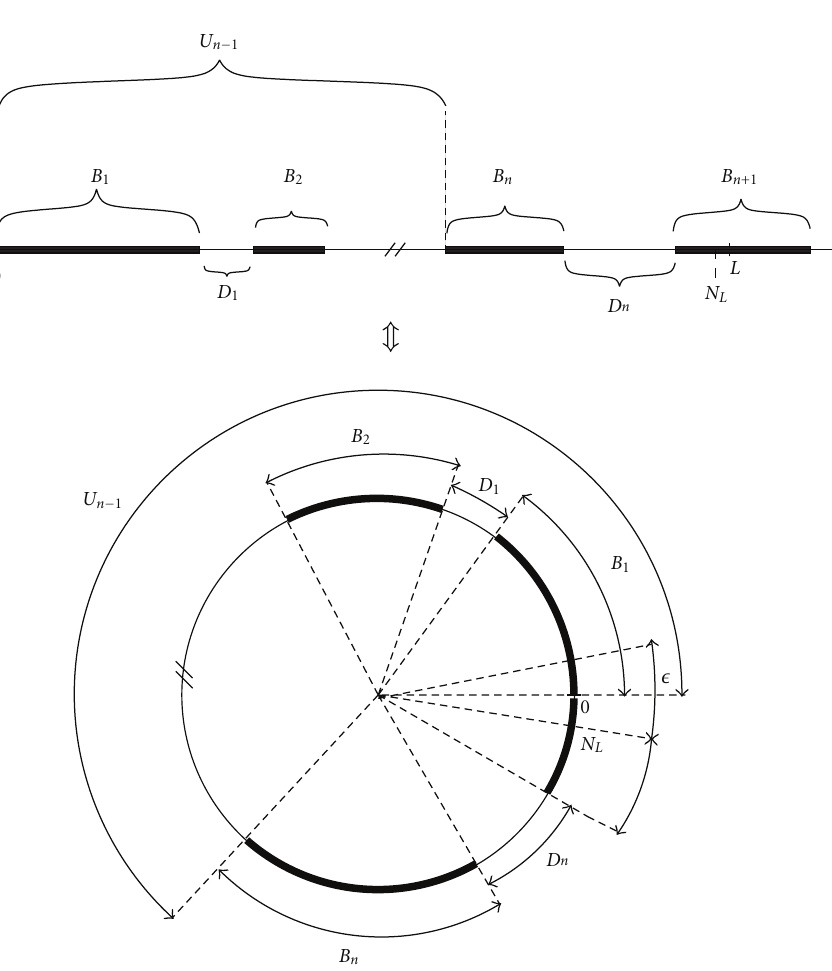
Figure 4: Illustration of the condition equivalent to χ (cid:4) L (cid:5) ≥ n . Since the coverage of the last point on (cid:2) 0 ,L (cid:3) overlaps the cluster with a point in zero, they are actually contained in the same